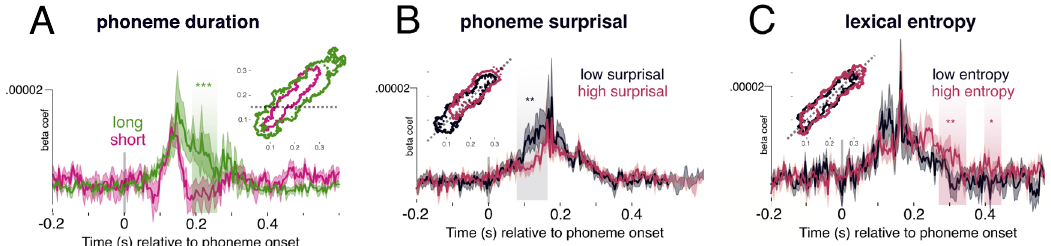
Fig. 5 | Manipulating axes of sequence dynamics. We fi nd that different prop- erties of the speech input modulate decoding latency, width and angle. A TG analysismediansplitintophonemelength:short(average45ms)andlong(average 135ms).Contourinlayrepresentsthebordersofthesigni fi canttemporalclustersat p<0.001, derived from a non-parametric randomised permutation procedure. Waveforms represent a horizontal slice at 140ms (shown as a dashed line in the contour plot). B Analysis on all non-onset phonemes split into median surprisal, along the diagonal plane (slice shown in contour plot). Highlighted areas show